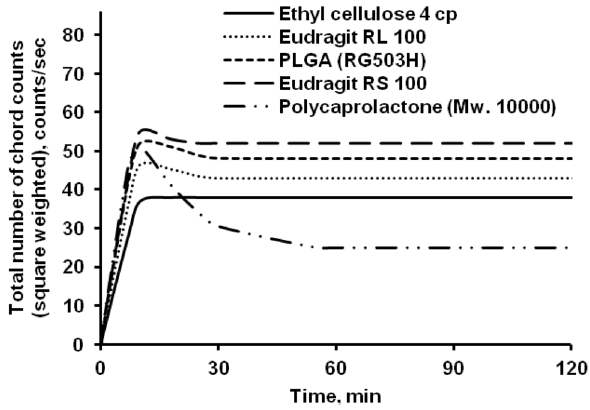
Figure 2. Effect of polymer type on the number of chord counts (square weighted) during solvent evaporation process.